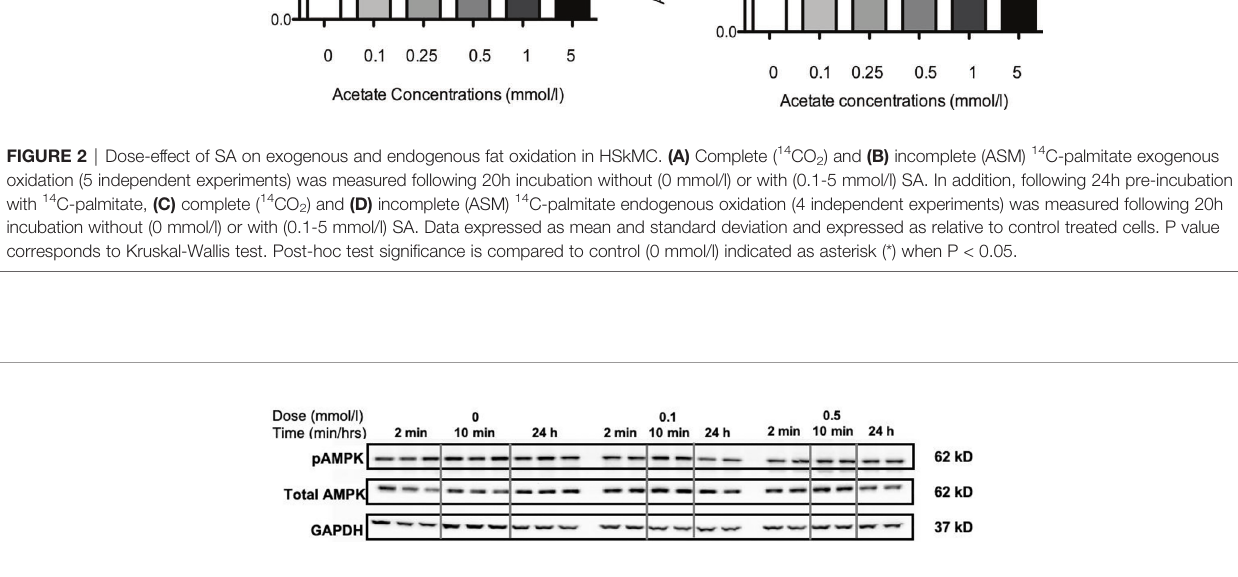
FIGURE 3 | Time and dose-dependent effects of SA on total and pAMPK in HSkMC . Cells were incubated without (0 mmol/l) and with (0.1 and 0.5 mmol/l) SA for 2 or 10 min and up to 24 h. After incubation, cells were lysed with RIPA buffer supplemented with protease and phosphatase inhibitors and samples were subjected to western analysis for total AMPK a (62kD band) , phosphorylated AMPK ( Thr 172 -AMPK a ) and GAPDH (37kD band) was used as a loading